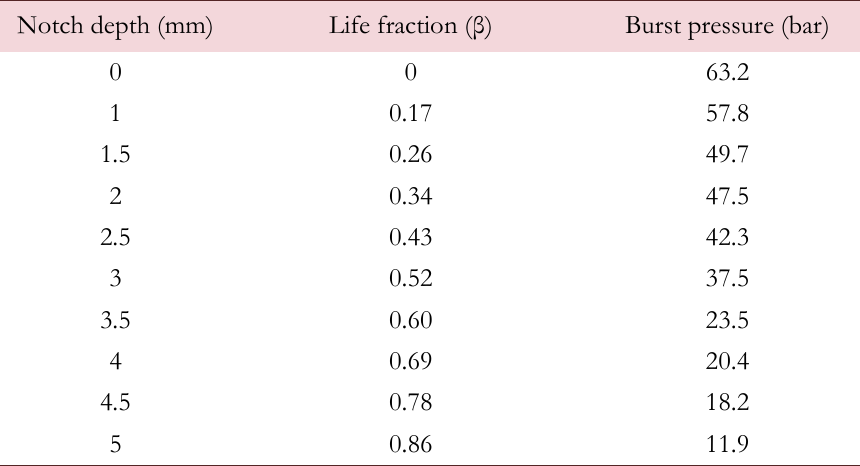
Table 1: Burst pressure evolution in function of the life